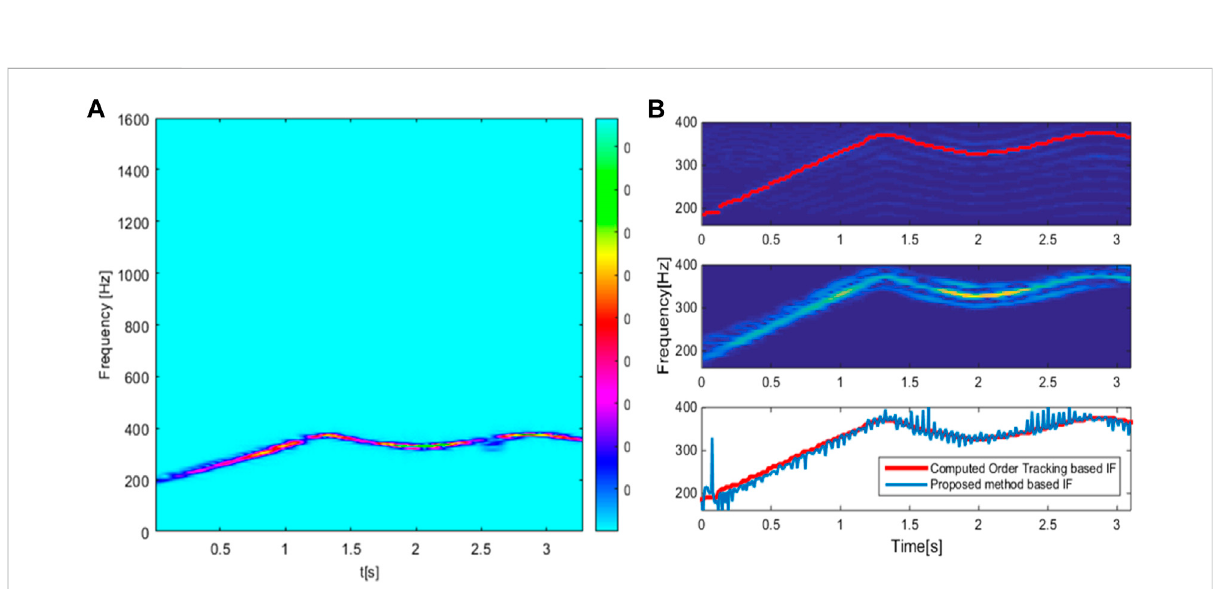
FIGURE 9 Meshing frequency extracted from the proposed method (A) and comparison with the COT method (B)